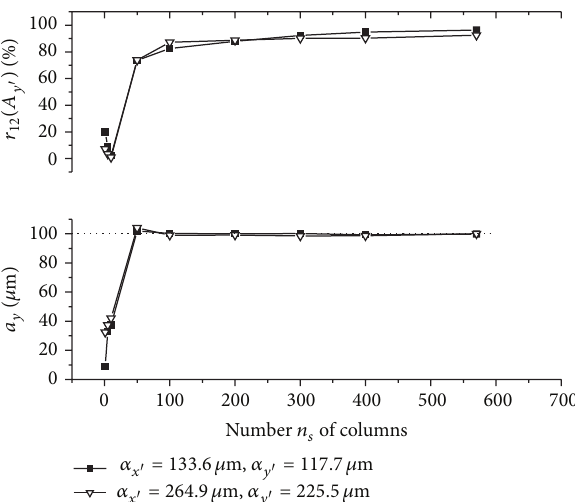
Figure 7: Resultant values of the evaluated object’s translation component 𝑎 𝑦 aswellasthemaximum 𝑟 12 (𝐴 𝑦 󸀠 ) ofthe1Dnormalized cross-correlation function 𝑟 12 of the intensity signals 𝐼 1 and 𝐼 2 as a function of number 𝑛 𝑠 of rows of the area used for the 2D intensity signal processing. The object is translated by 𝑎 𝑥 = 10𝜇 m and 𝑎 𝑦 = 0 𝜇 m.